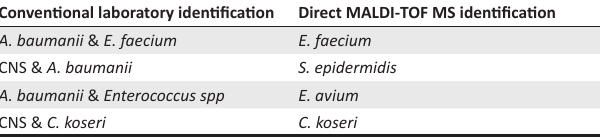
TABLE 6: Four polymicrobial blood cultures and direct identification by MALDI-TOF MS ( N = 4), Bloemfontein, South Africa, 15 July 2013 to 30 September